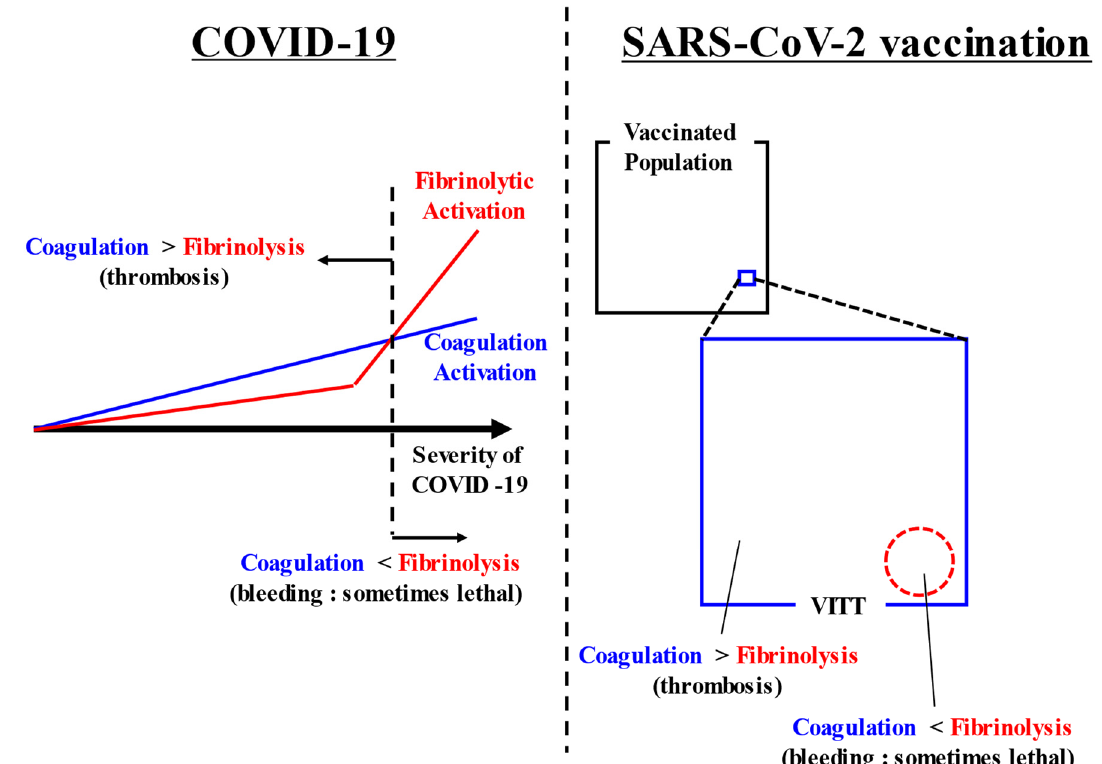
Figure 1. Summarizing figure. COVID-19 causes coagulation activation depending on its severity. In addition, some cases of severe COVID-19 have markedly increased fibrinolysis. Thrombosis appears as the main symptom when coagulation activation exceeds fibrinolytic activation. Conversely, bleeding appears as the main symptom when fibrinolytic activation exceeds coagulation activation. After SARS-CoV-2 vaccination, VITT rarely occurs. In most cases, coagulation activation exceeds fibrinolytic activation and thrombosis occurs, but in some cases, bleeding appears when fibrinolytic activation exceeds coagulation activation. Abbreviations: COVID-19, coronavirus disease 2019; SARS-CoV-2, severe acute respiratory syndrome coronavirus 2; VITT, vaccine-induced immune thrombotic thrombocytopenia.